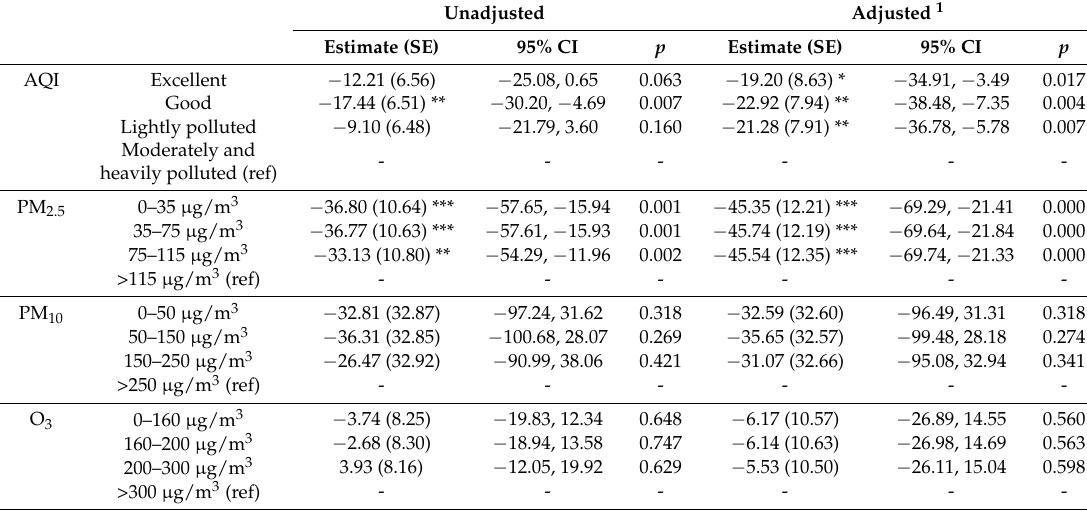
Table 4. Associations between air quality and sedentary time